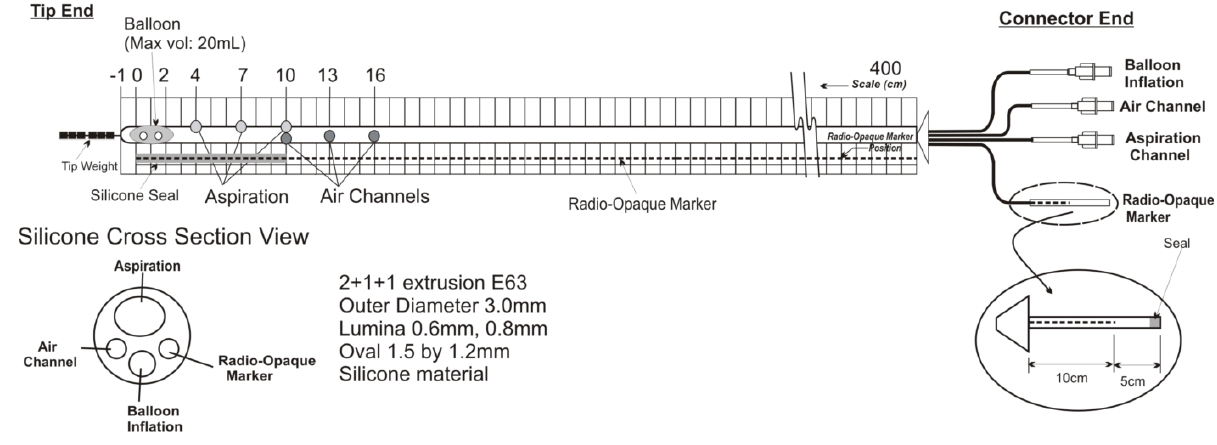
Figure 2. Nasoenteric tube design. Published with permission from MUI Scientific.